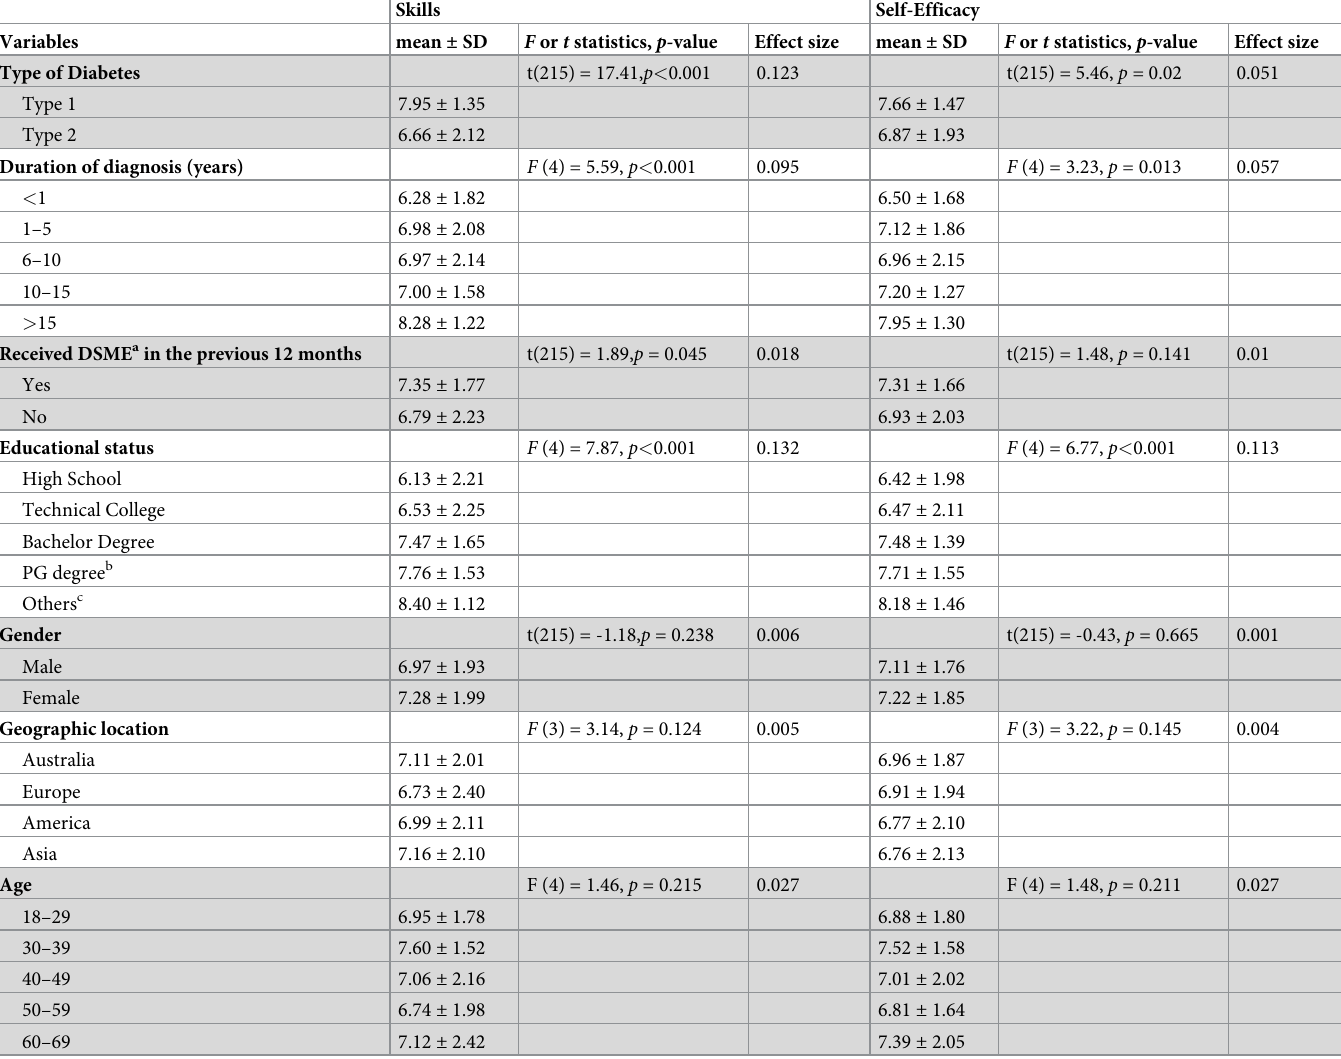
Table 2. Summary of t-test or ANOVA and post hoc results on mean scores by participants’